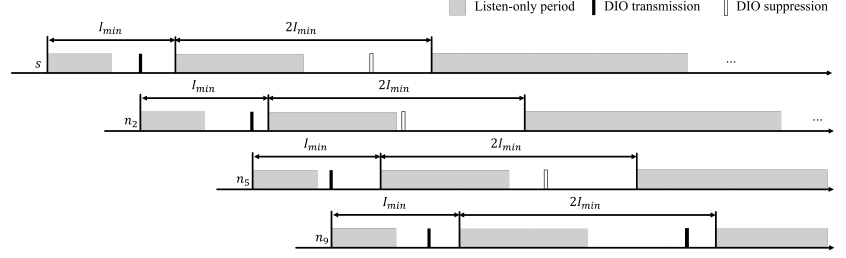
Figure 8. Standard trickle timer in 3D